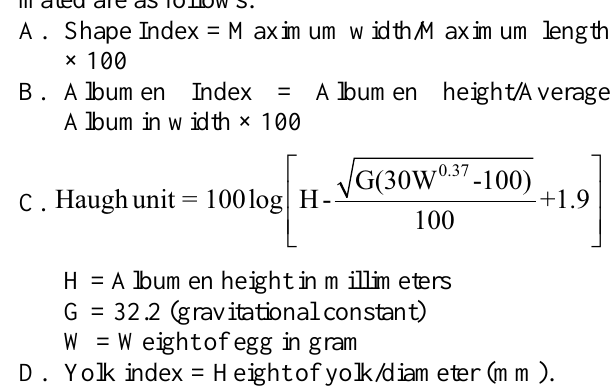
Table-1: Ingredients and nutrient composition of the poultry feeds used in the study. Ingredient Starter